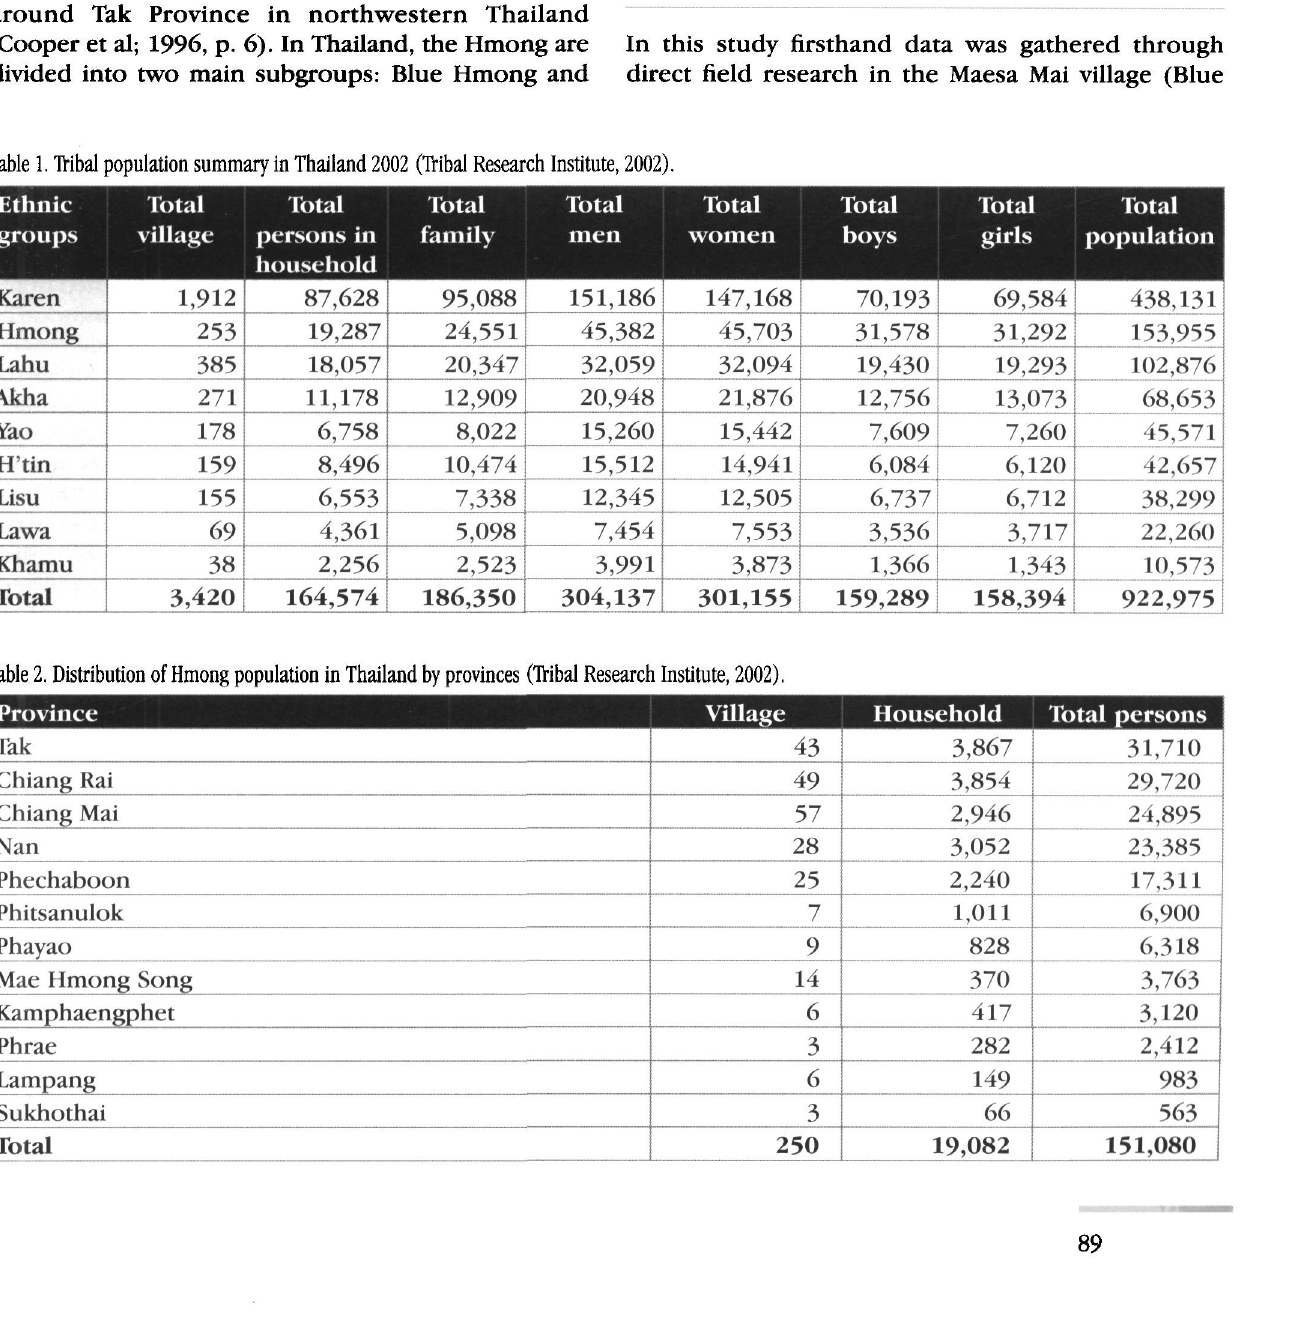
Table 2. Distribution of Hmong population in Thailand by provinces (Tribal Research Institute,